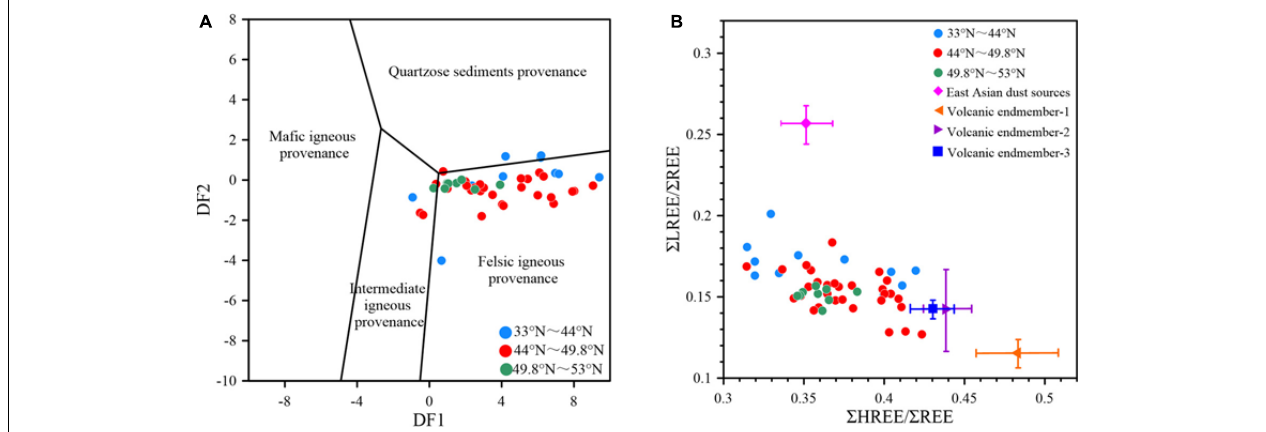
FIGURE 12 | Discrimination plot of the nature of parental rock of sediment provenance (A) and the scatter plot of (LREE/REE) N and (HREE/REE) N (B) , east Asian dust sources and volcanic sources refer to Serno et al.